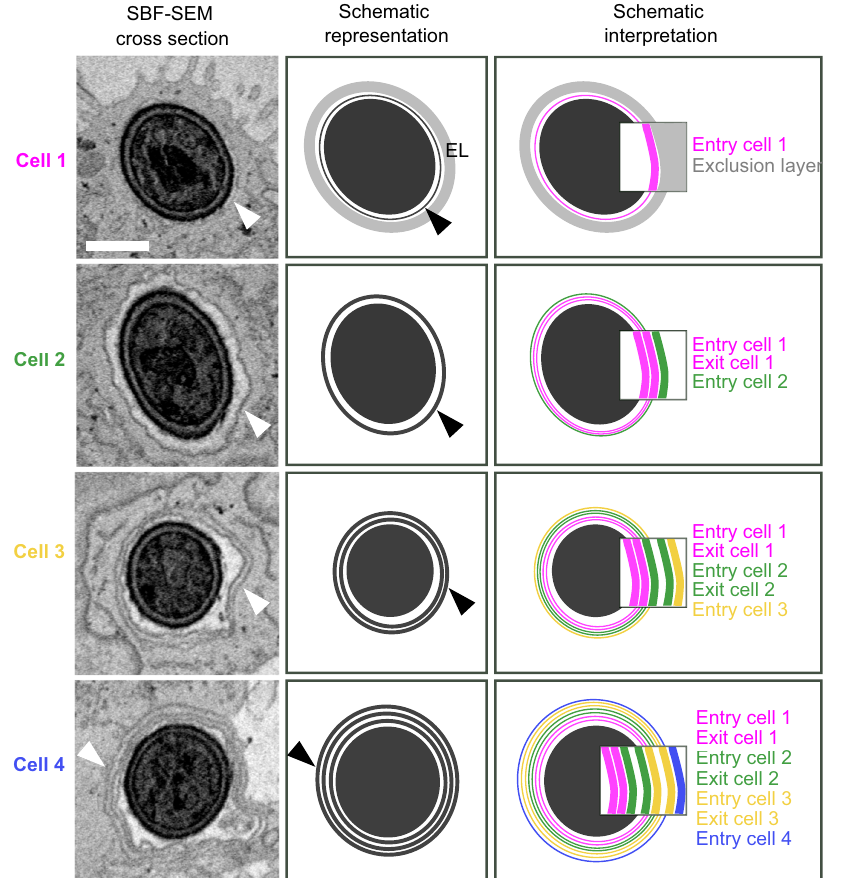
Fig. 5 Host membrane organization around a single hypha invading four Caco-2 cells in sequence. Data presented is derived from an SBF-SEM volume containing a single invasion event through four host cells in sequence. A representative section from each invaded host cell in the invasion sequence is presented alongside a schematic representation, illustrating the exclusion layer (EL) and host membrane organization around the hypha in each invaded cell. Arrowheads indicate observed membranes and their corresponding schematic representation. A schematic interpretation is also presented, corresponding to the hypothesis that host membranes extend from each invaded cell into the next host cell in the invasion sequence, resulting in progressive membrane layer accumulation. Insets show in detail inferred membrane organization in accordance with this hypothesis, with each layer derived from a plasma membrane deformed upon hypha entry or exit from each corresponding invaded cell. The presented dataset corresponds to invasion site 9 in Supplementary Table 2 and is presented in Supplementary Movie 14. Scale bar is 1 µ